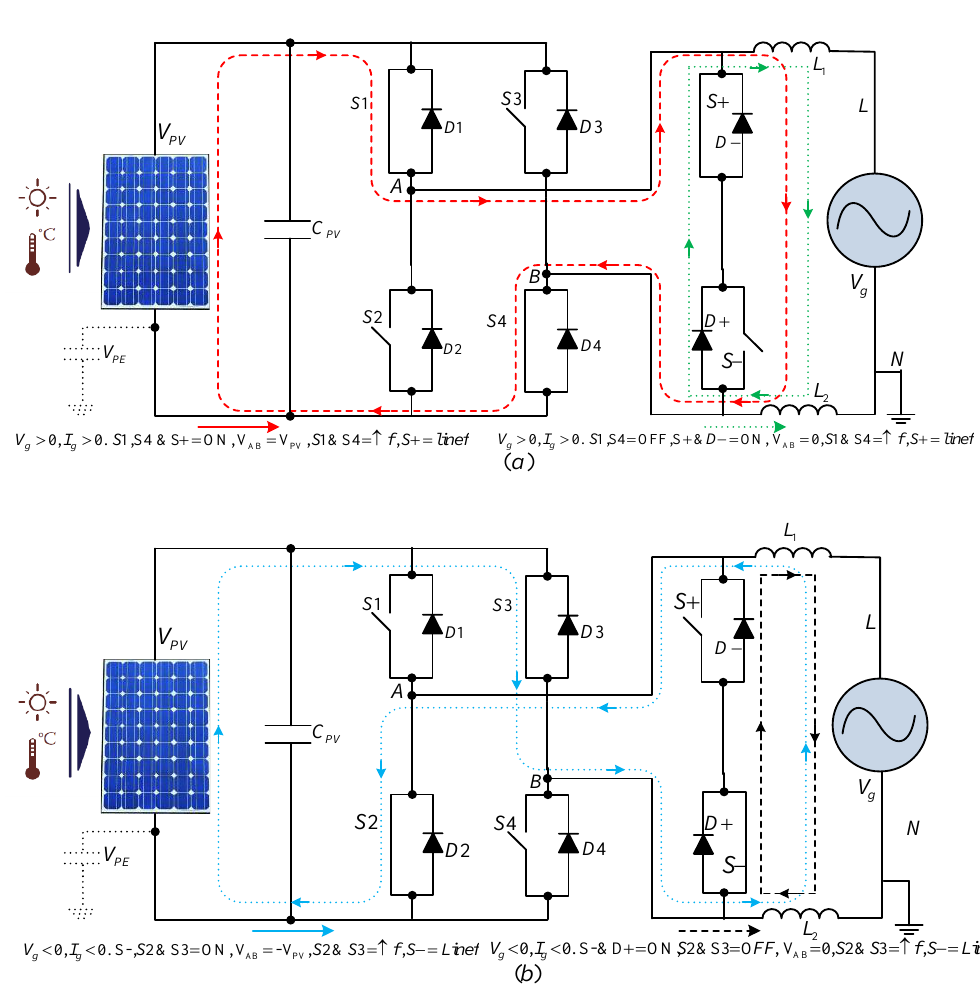
Figure 10. Switching states of the Sunways HEREIC concept in case of: ( a ) positive cycle and ( b ) negative cycle [29,30].